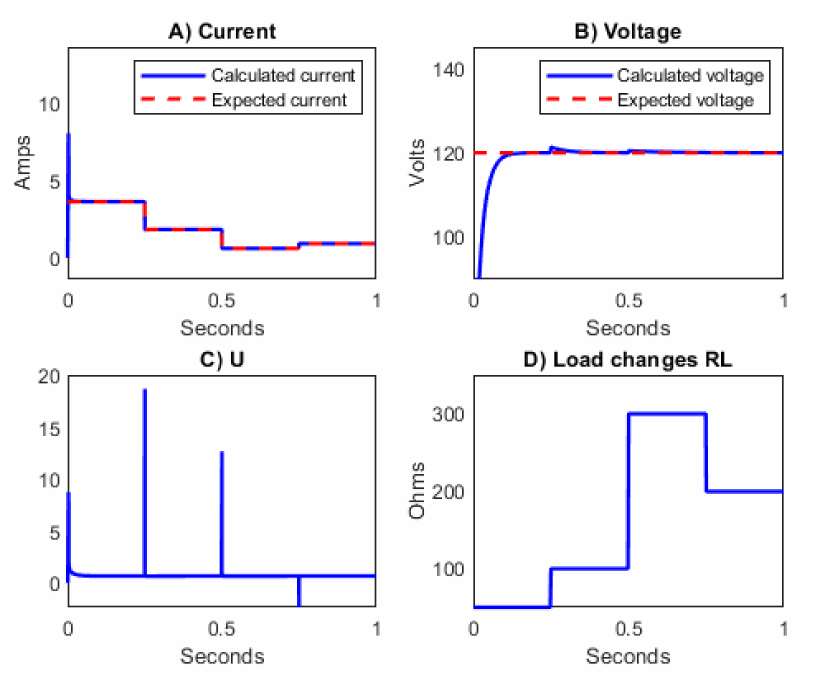
Figure 4. ( A ) Shows current behavior, ( B ) boost converter output voltage, ( C ) duty cycle, and ( D ) changes in